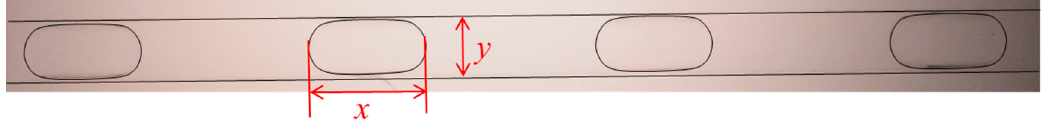
Figure 3. Schematic diagram of measurement mode.